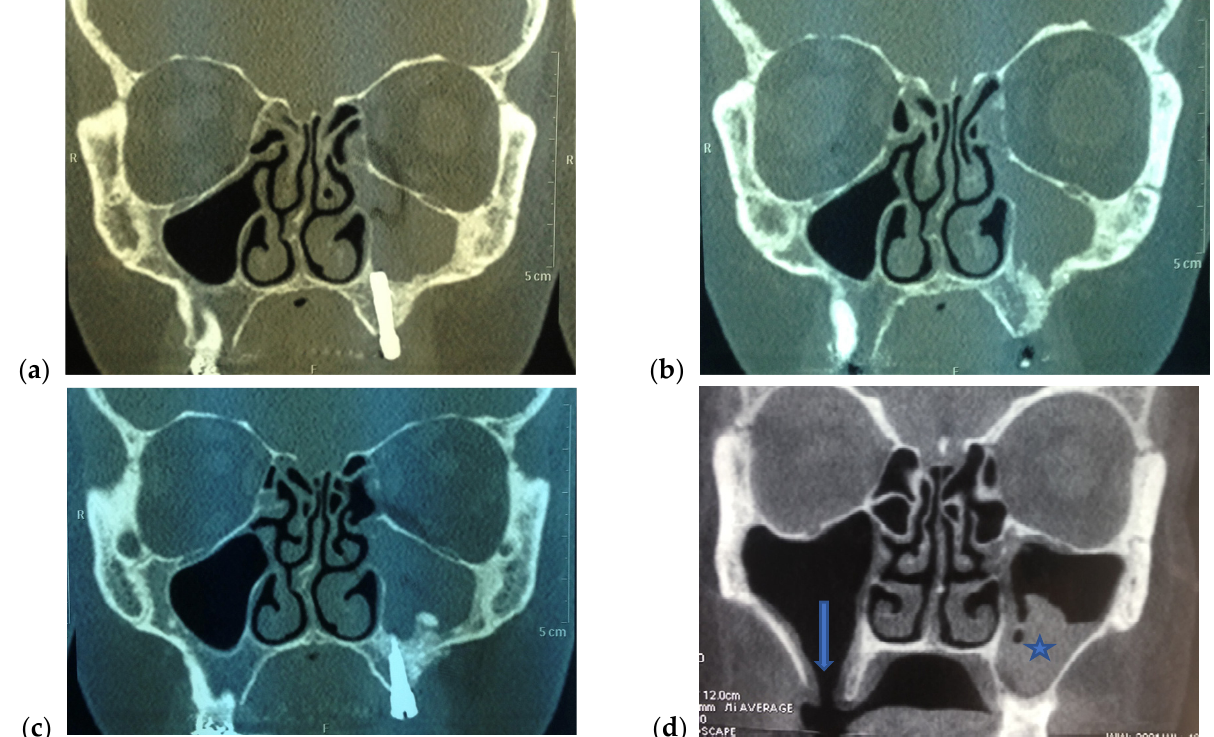
Figure 1. Computed tomography demonstrating iatrogenic left maxillary sinusitis secondary to ( a ) dental implant; ( b ) sinus lift; ( c ) sinus lift and dental implant and; ( d ) oro-antral fistula on the right (arrow) and evidence of a fungal ball and obstructed osteomeatal complex on the left (star).